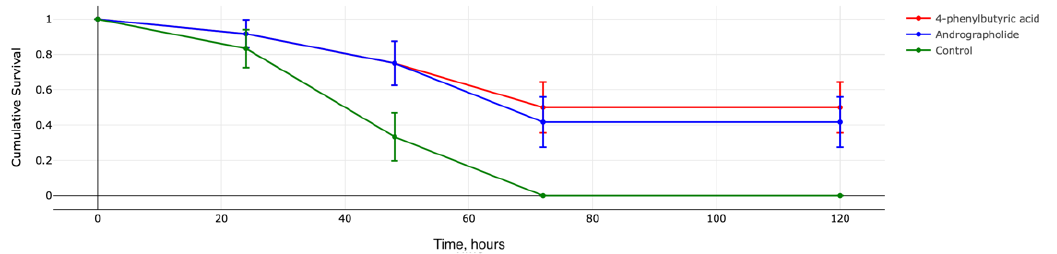
Figure 4. Survival function with standard error. Survival was assessed by the Kaplan – Meier method. Statistically significant differences with p = 0.0394525 were found between the control group (sterile saline) and the two experimental groups (andrographolide – 80 mg/kg and 4-phenyl- butyric acid – 500 mg/kg).